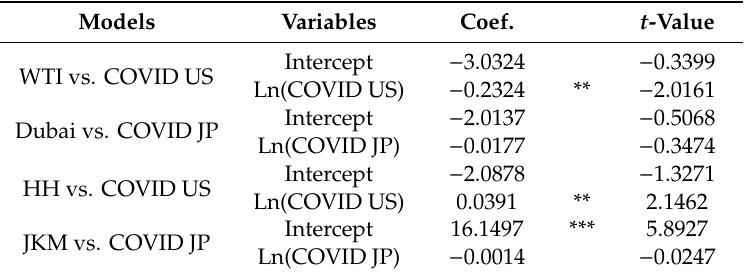
Table 7. Long-run coe ffi cients estimation.